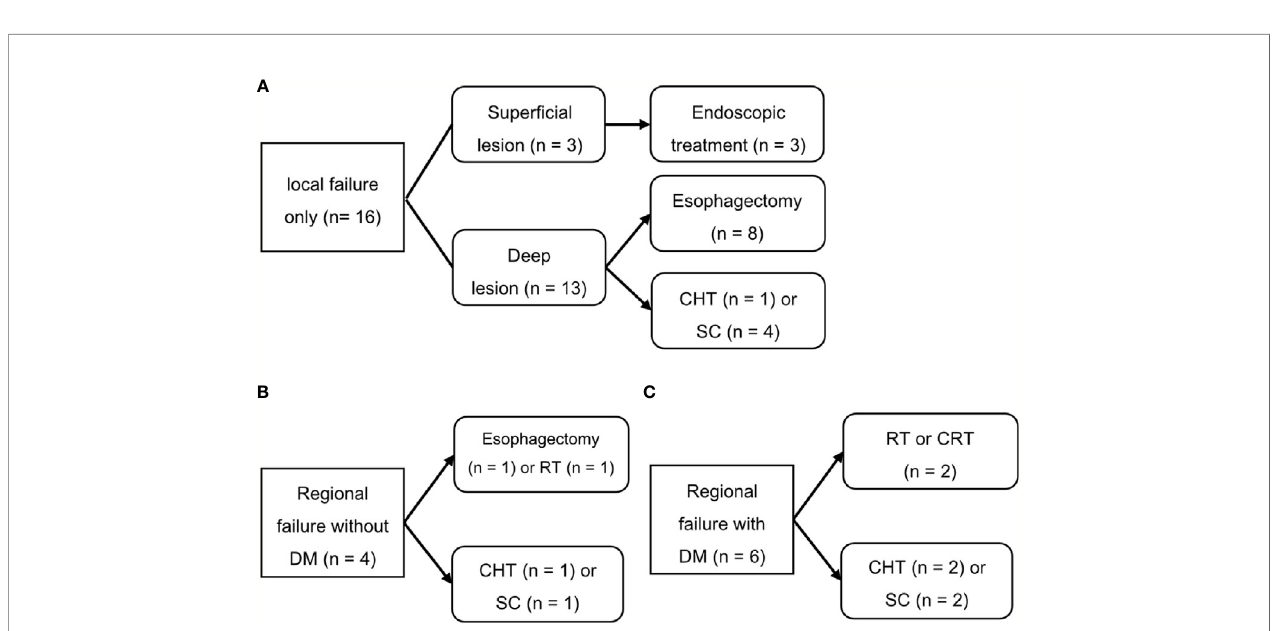
FIGURE 4 | Salvage treatment scheme for patients who experienced isolated local recurrence (A) , regional recurrence without distant metastasis (B) , or distant metastasis (C) . SC, supportive care; CHT, chemotherapy; CRT, chemoradiotherapy; DM, distant metastasis; RT, radiotherapy.